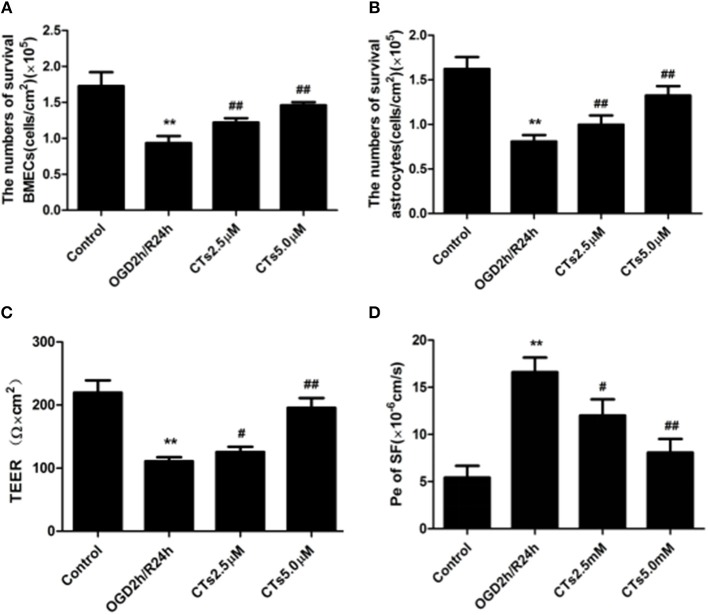
CTs improved the BBB function in OGD/R-injured NVU model. (A,B) The numbers of survival BMECs and astrocytes were detected by trypan blue stain.The values were expressed as cells/cm2 (n = 4). (C) TEER value was measured using a Millicell ERS-2 Voltohmmeter. The values were calculated according to the corresponding formula, and were expressed as Ω × cm2 (n = 4). (D) Pe of SF was calculated according to the corresponding methods. Pe were expressed as × 10−6cm/s (n = 4). The detection results showed CTs had an effect of protecting BBB function from OGD/R injury. Data are presented as the mean ± SD. **P < 0.01 vs. Control group; #P < 0.05, ##P < 0.01 vs. OGD2h/R24h group. BMECs, brain microvascular endothelial cells; TEER, transepithelial electrical resistance; Pe, permeability coefficient; SF, sodium fluorescein; CTs, cryptotanshinone.